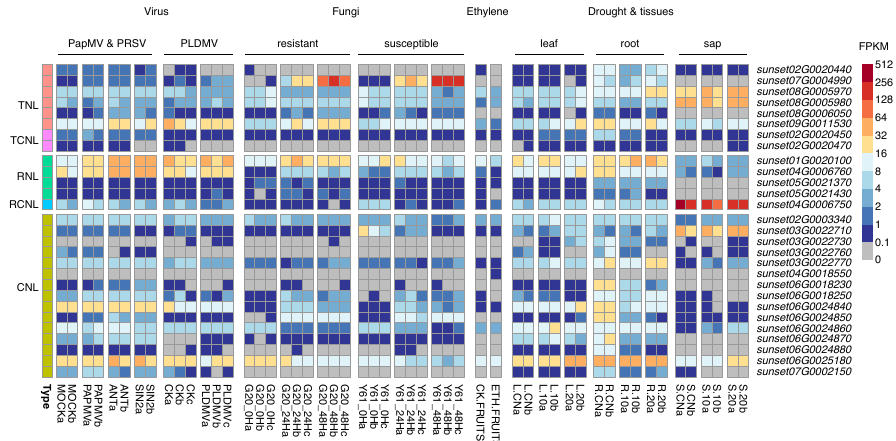
Figure A2. FPKM values of NLRs in papaya under biotic and abiotic stresses. ANT indicates ‘Antagonism’ samples, which are inoculated with simultaneous PapMV and PRSV [47]. SIN2 indicates ‘Sinergism2’ samples, which are inoculated with stepwise PapMV and PRSV